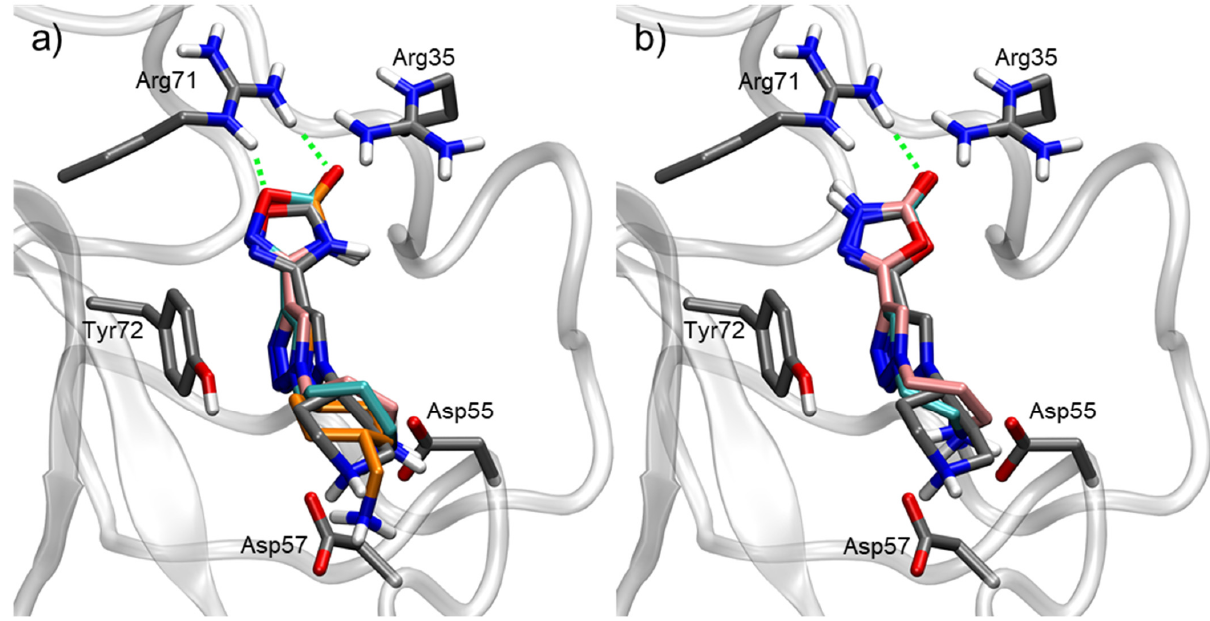
Figure 5. Docking of most representative poses for 1,2,3-triazole derivatives combined with oxadi- azolone rings. ( a ) 1,2,4-oxadiazolone compounds: 1 (grey), 2 (pink), 3 (cyan), 4 (orange). ( b ) 1,3,4- oxadiazolone compounds: 5 (grey), 6 (cyan), 7 (pink). Docking studies were performed with Kringle 1 lysine binding site (pdb code 1cea) using AutoDock 4.2. H-bond interactions with the oxadia- zolone ring are indicated as green dashed lines.